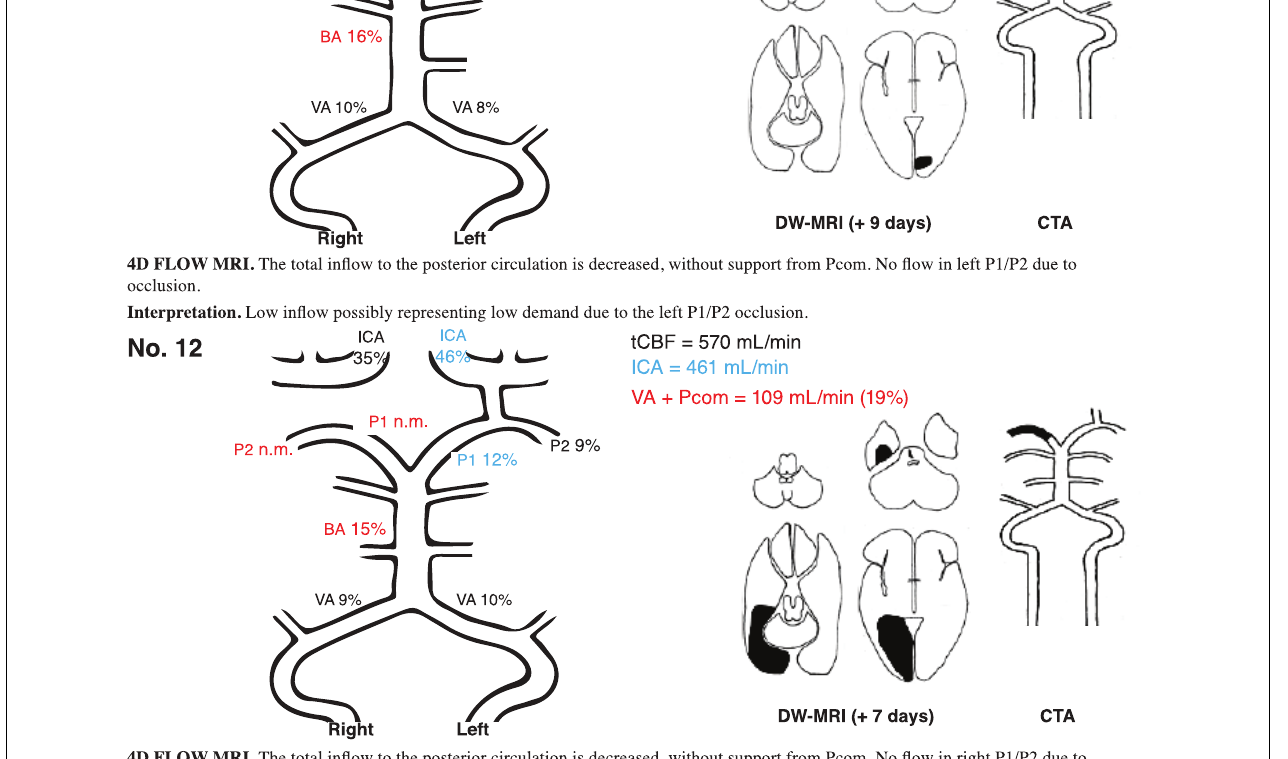
Frontiers in Neuroscience |